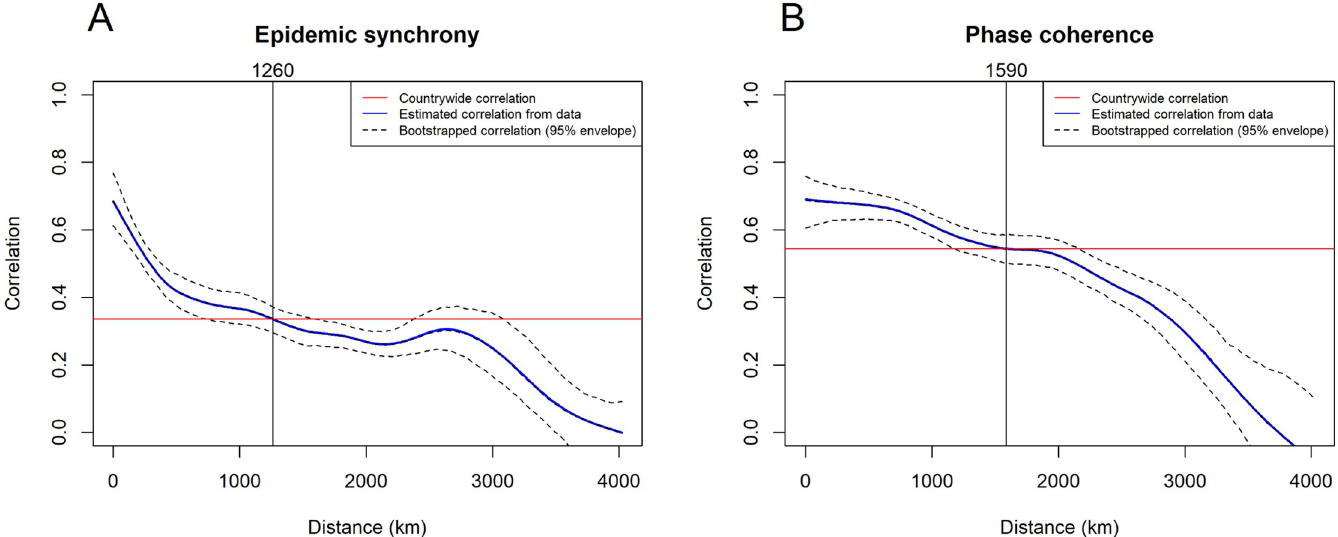
Fig 3. Epidemic synchrony and annual phase coherence between Brazilian Urban-2 regions. Epidemic synchrony (A) and annual phase coherence (B) summarised using nonparametric spline covariance function. Solid blue line describes the mean pairwise correlation from the data and the dotted lines represent the 95% envelope for bootstrapped correlations of case and annual phase angle time series, respectively. Red line indicates global countrywide correlation.